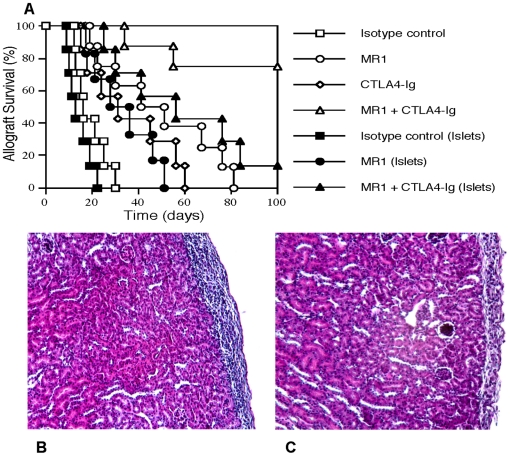
CD154/CD28 blockade induces long-term IPCC, but not freshly isolated islet, allograft survival in diabetic NOD mice.IPCCs that differentiated from Fas-deficient ASCs derived from MRL.MpJ.Fas-/- (H-2k) mice were transplanted to diabetic NOD mice that were treated with isotype Ab (Open square, n = 7), MR1 (Open circle, n = 8), CTLA4-Ig (Open diamond, n = 7), or MR1 plus CTLA4-Ig (Open triangle, n = 8). As controls, freshly isolated islets from MRL.MpJ.Fas-/- donor mice were also transplanted to NOD mice that were treated with isotype Ab (Filled square, n = 7), MR1 (Filled circle, n = 6), or MR1 plus CTLA4-Ig (Filled triangle, n = 7). Graft survival was observed (A). H&E staining of kidneys harboring IPCC allografts derived from a control (B) or MR1+CTLA4-Ig treated recipient (C) was performed either at the time of graft rejection or 100 days after IPCC transplantation and survival.